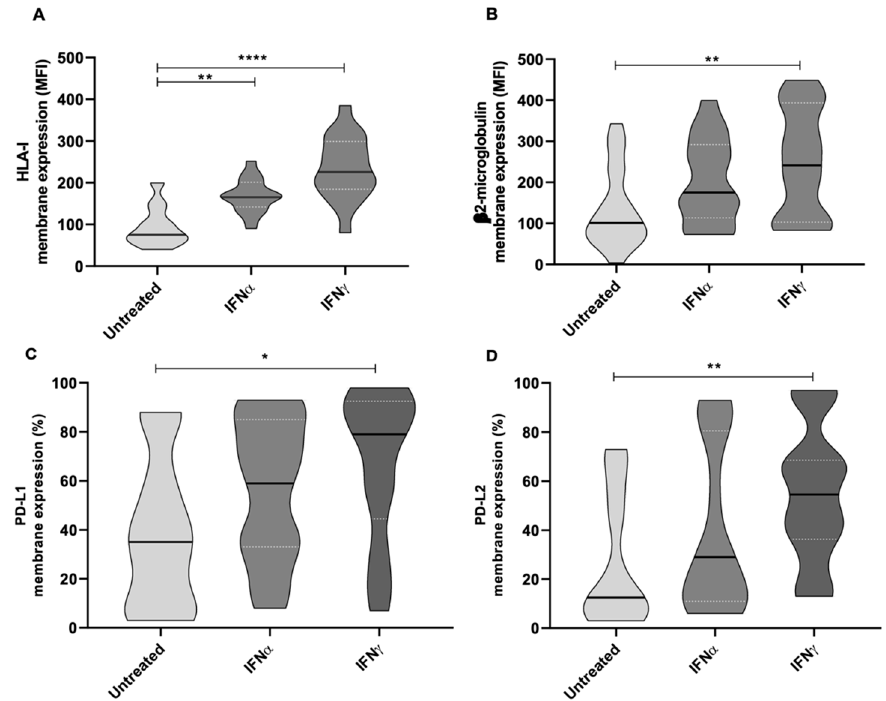
Figure 8. Modulation of HLA-I, β 2-microglobulin, PD-L1 and PD-L2 expression mediated by IFNs in wtGISTc. IFNs determined a significant enhancement in the expression of HLA-I/B2M and immune checkpoints (PDL-1/2) in wtGISTc. All the reported values were compared to untreated controls and expressed in MFI. (**** p < 0.0001; ** p < 0.005; * p < 0.05; nonparametric t -test).